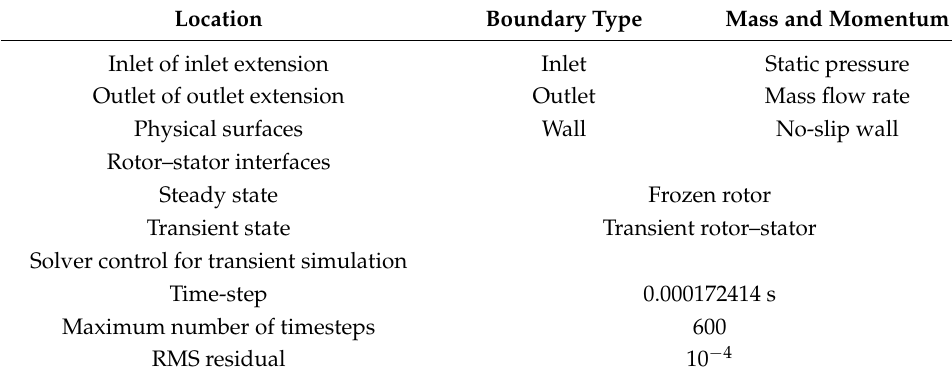
Figure 4. Schematic diagram of impeller grid y +. Table 2. Setting mode of